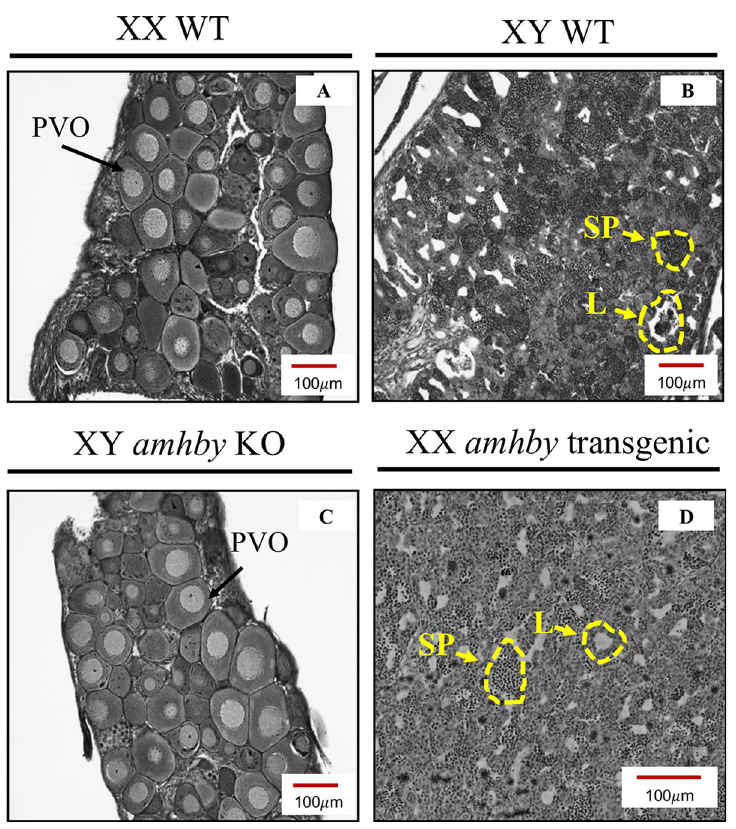
Fig 4. Gonadal phenotypes of E . lucius in amhby knockout (KO) and additive transgenesis experiments. Gonadal histology of a representative control XX female (A), control XY male (B), an amhby KO XY individual (C), and an amhby transgenic XX mutant (D). The amhby KO XY individual (C) developed ovaries with oocytes and an ovary cavity, indistinguishable from the ovary of the control females (A). The amhby transgenic XX mutant individual (D) developed testis with clusters of spermatozoids and testicular lobules identical to that of the control males (B). PVO : previtellogenic oocytes; SP : spermatozoids; L : testicular lobules; T : testis; and O : ovary.